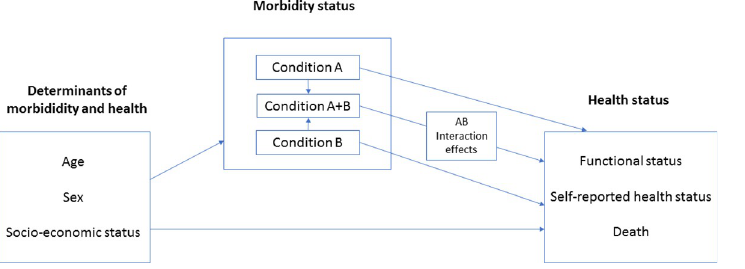
Fig 1. Schematic diagram of the conceptual model assumed in this